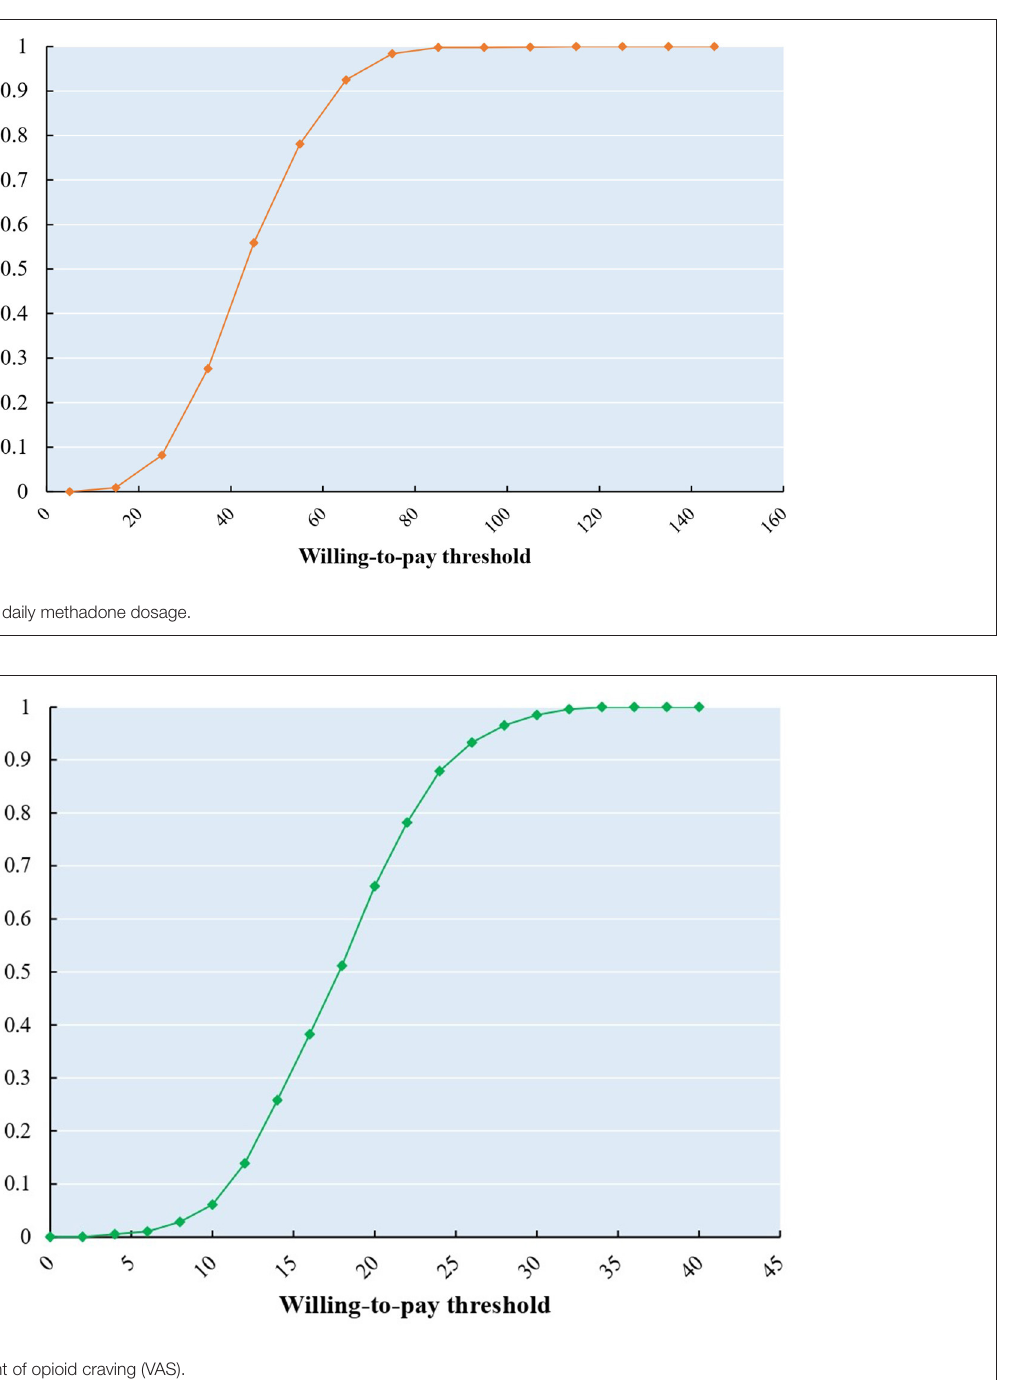
FIGURE 3 | CEAS of improvement of opioid craving